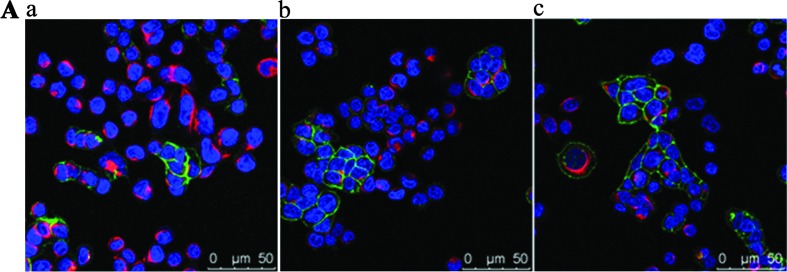
(A) Confocal immunofluorescence images showing the expression of vimentin (red) and E-cadherin (green) in the SW620 cells after 24 h treatment with (a) PAR1-activated platelet supernatant, (b) non-activated platelet supernatant and (c) no treatment. SP magnification, ×400. (B) Expression of E-cadherin or vimentin protein in the SW620 cells detected by western blotting. (a) PAR1-activated platelets supernatant, (b) non-activated platelets supernatant and (c) medium control. PAR1, protease-activated receptor-1.